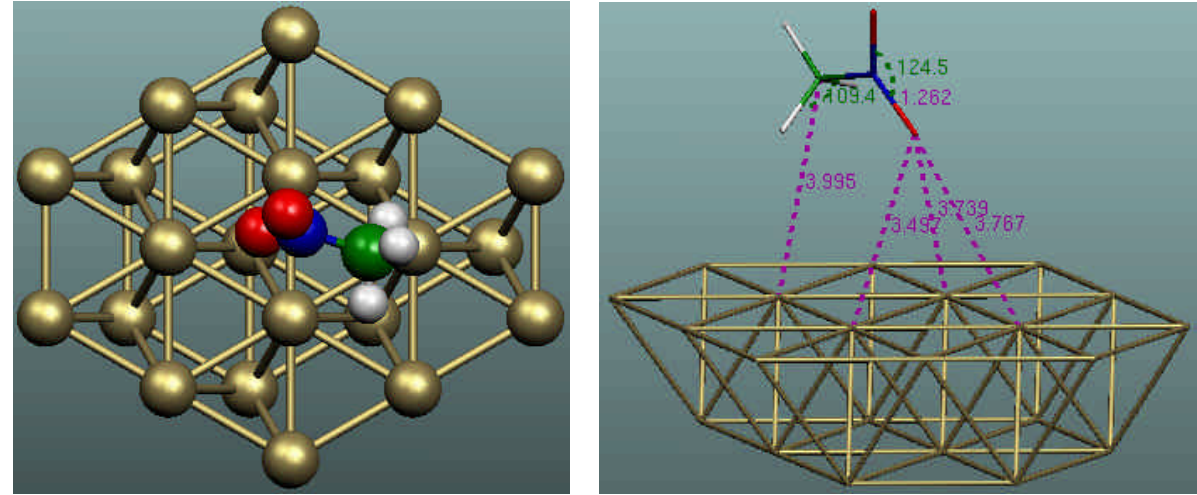
Figure 4. Top and side views of the final optimized geometry for the nitromethane molecule adsorbed on the Au(111)